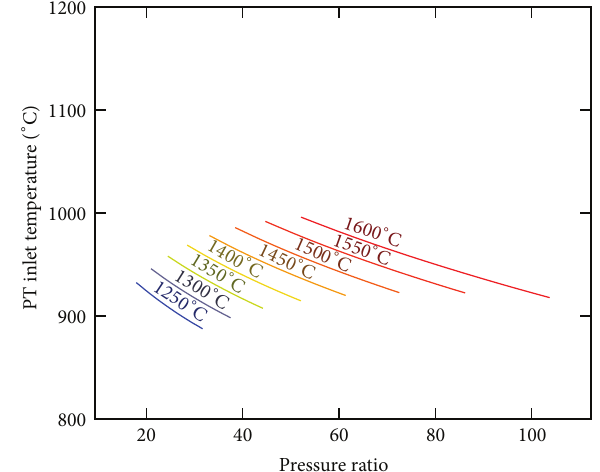
Figure 8: Power turbine entry temperature as function of pressure ratio and turbine entry temperature for the SCOC-CC.